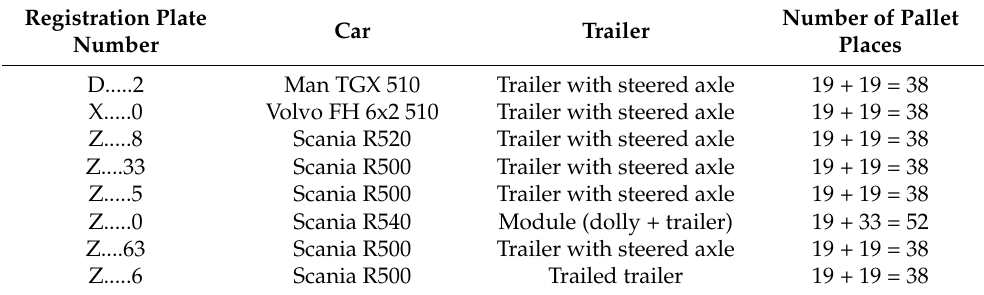
Table 1. Technical data of vehicles.